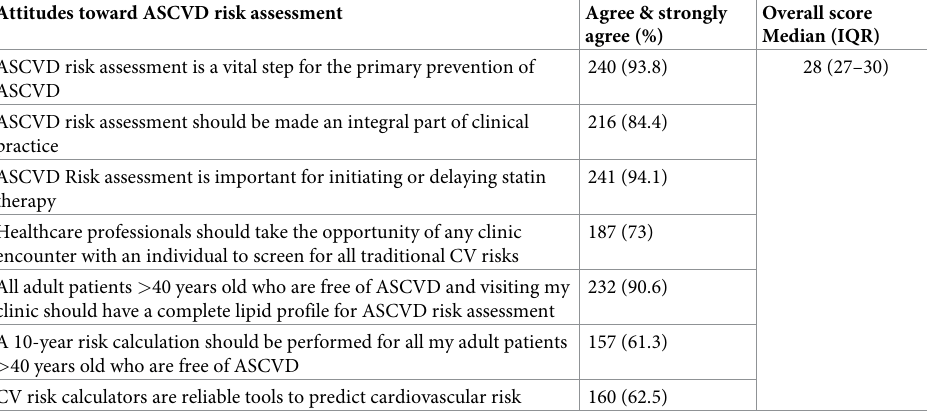
Table 6. Physicians’ attitudes toward ASCVD risk assessment. Attitudes toward ASCVD risk